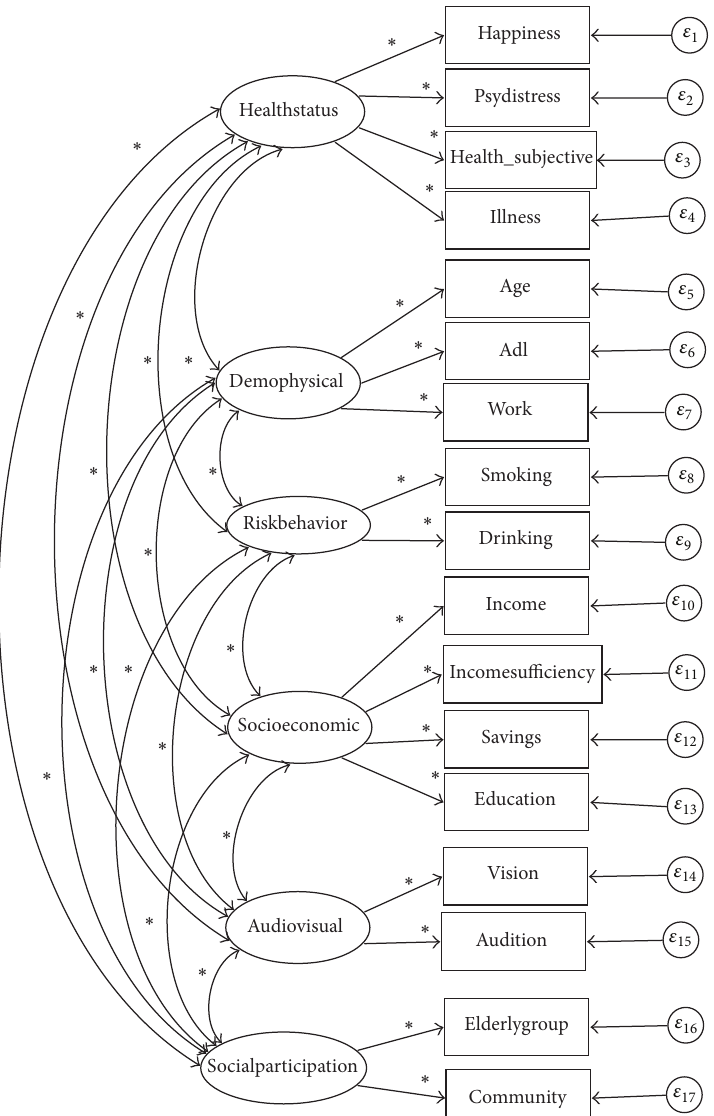
Figure 2: Hypothesized active ageing determinant factors model for male older persons in Thailand. Source: figure is constructed from Haque et al.’s study